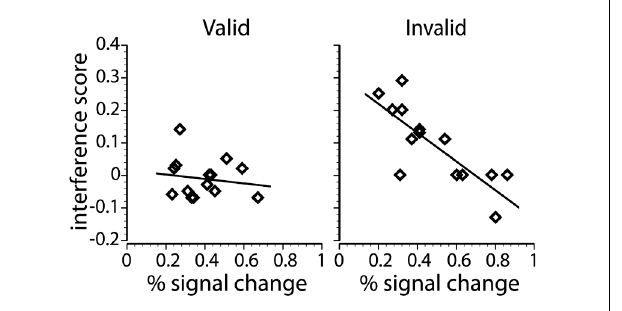
FIGURE 4 | Regression scatterplots that show the relationship between the peak percent signal change in the left IPS and the behavioral interference score for each individual subject on valid low load trials (left) and invalid low load trials